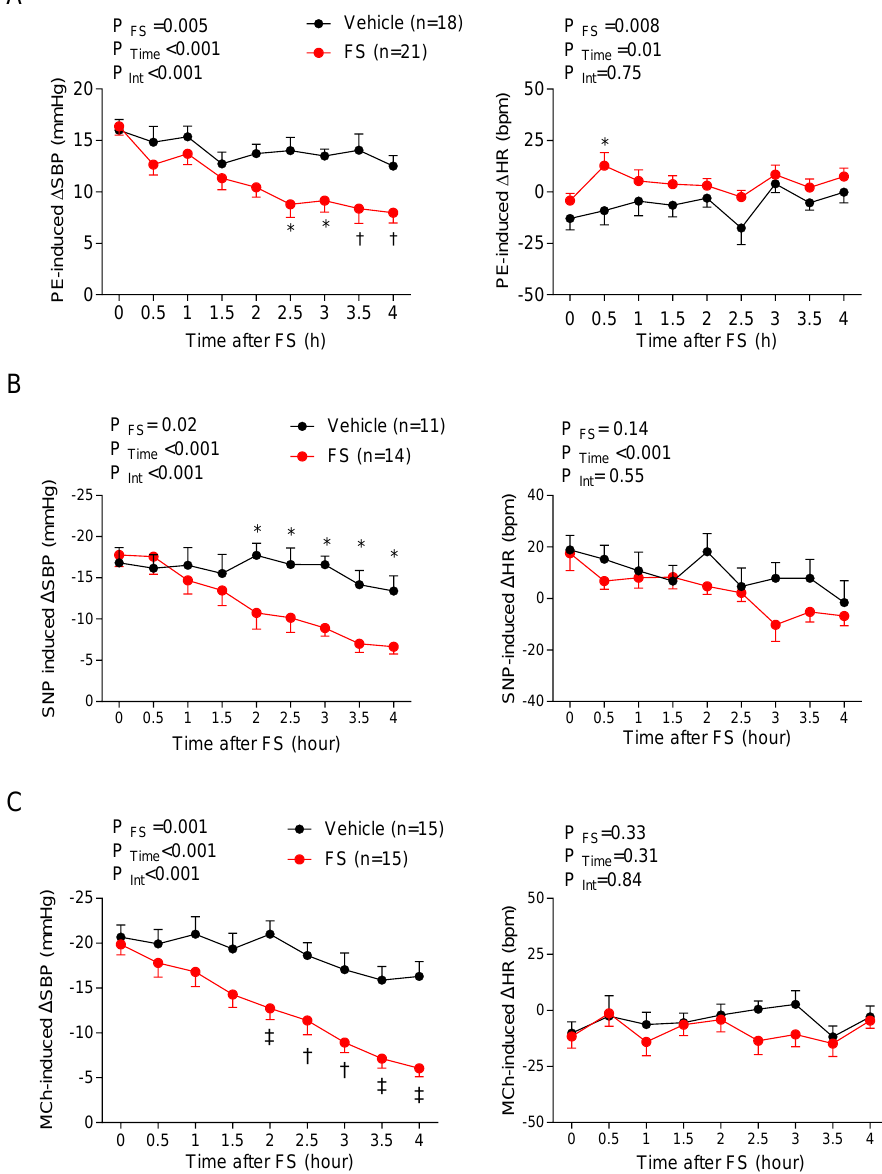
Figure 3. Fecal slurry (FS)-induced peritonitis caused a progressive reduction in systolic blood pres- sure (SBP) response (left panels) to bolus doses of ( A ) phenylephrine (PE), ( B ) sodium nitroprusside (SNP), and ( C ) methylcholine (MCh) over time in mice, with minimal changes in heart rate (HR, right panels). Data were analyzed by two-way ANOVA for the effects of FS and time, followed by the Holm–Sidak post hoc test for multiple comparisons. * p < 0.05, † p < 0.01, and ‡ p < 0.001 compared with the vehicle at the same time.